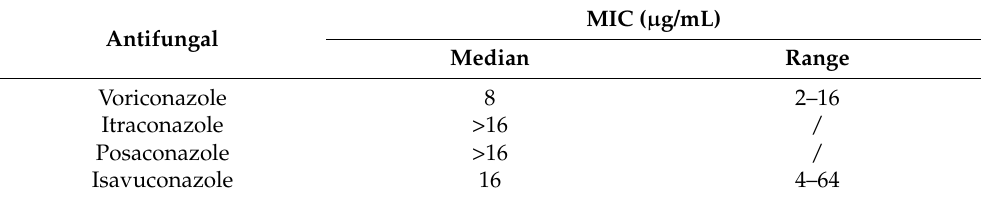
Table 4. Antifungal susceptibility results of FSSC strains: MIC median and ranges.